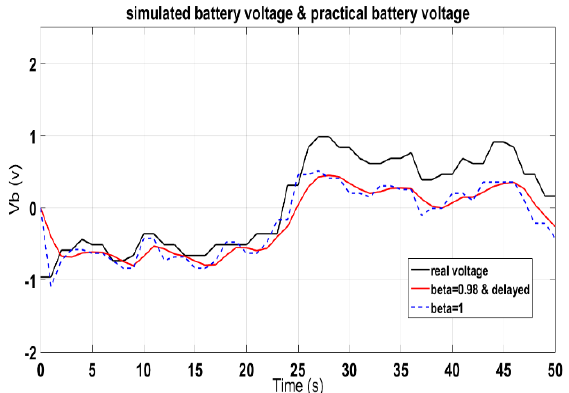
Figure 12. Comparison between practical and simulated battery